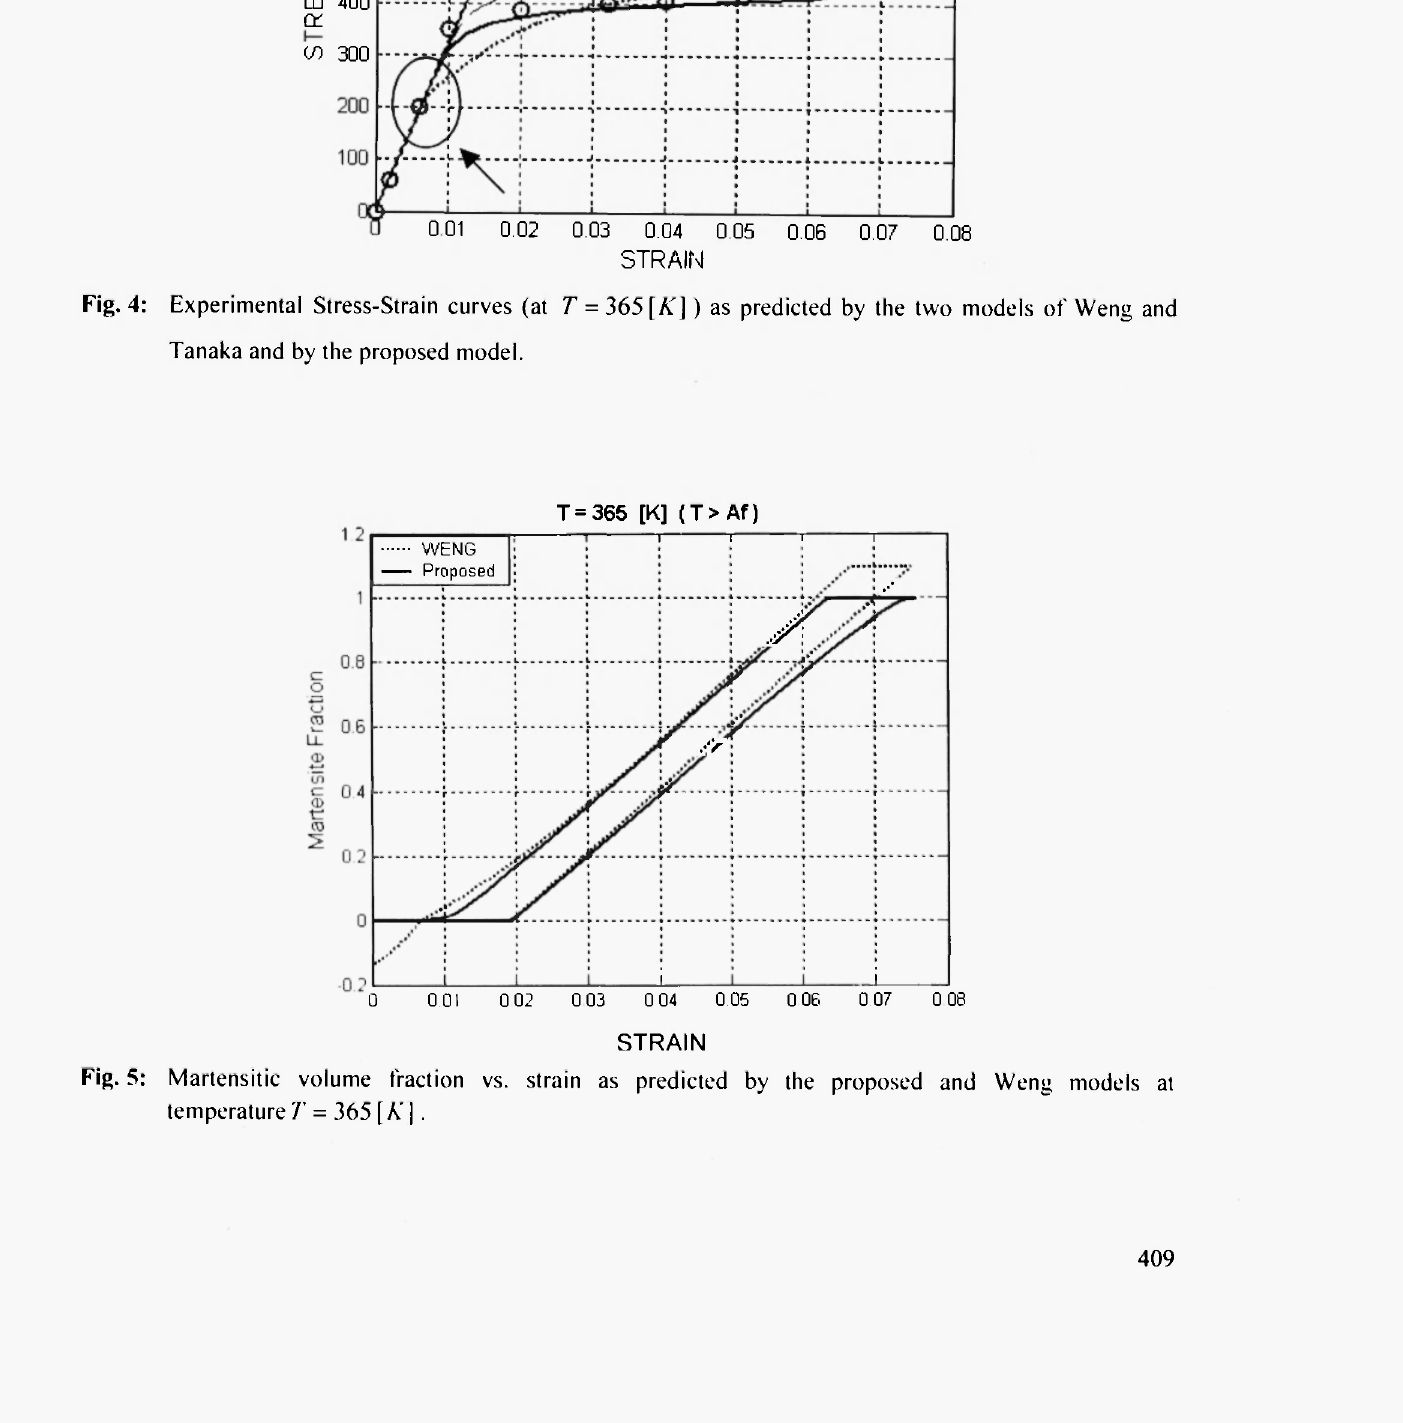
Fig. 5: Martensitic volume fraction vs. strain as predicted by the proposed and Weng models at temperature Τ = 365 [ A'